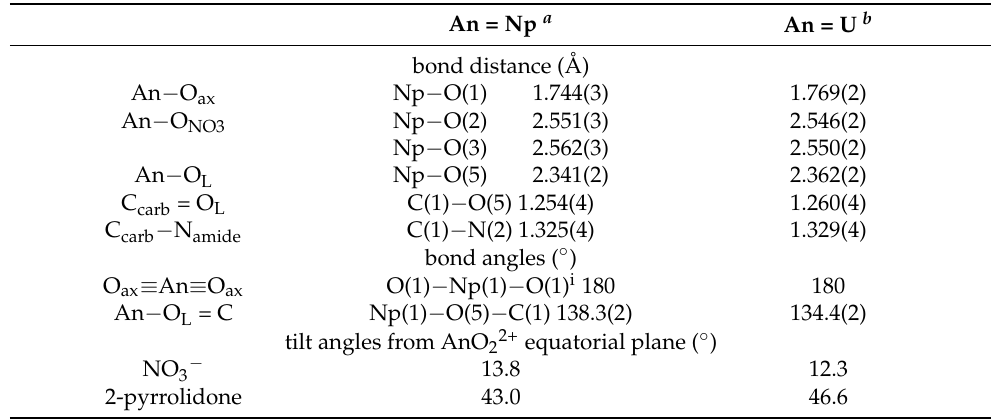
Table 2. Selected structural parameters of [AnO 2 (NO 3 ) 2 ( L1 )] n